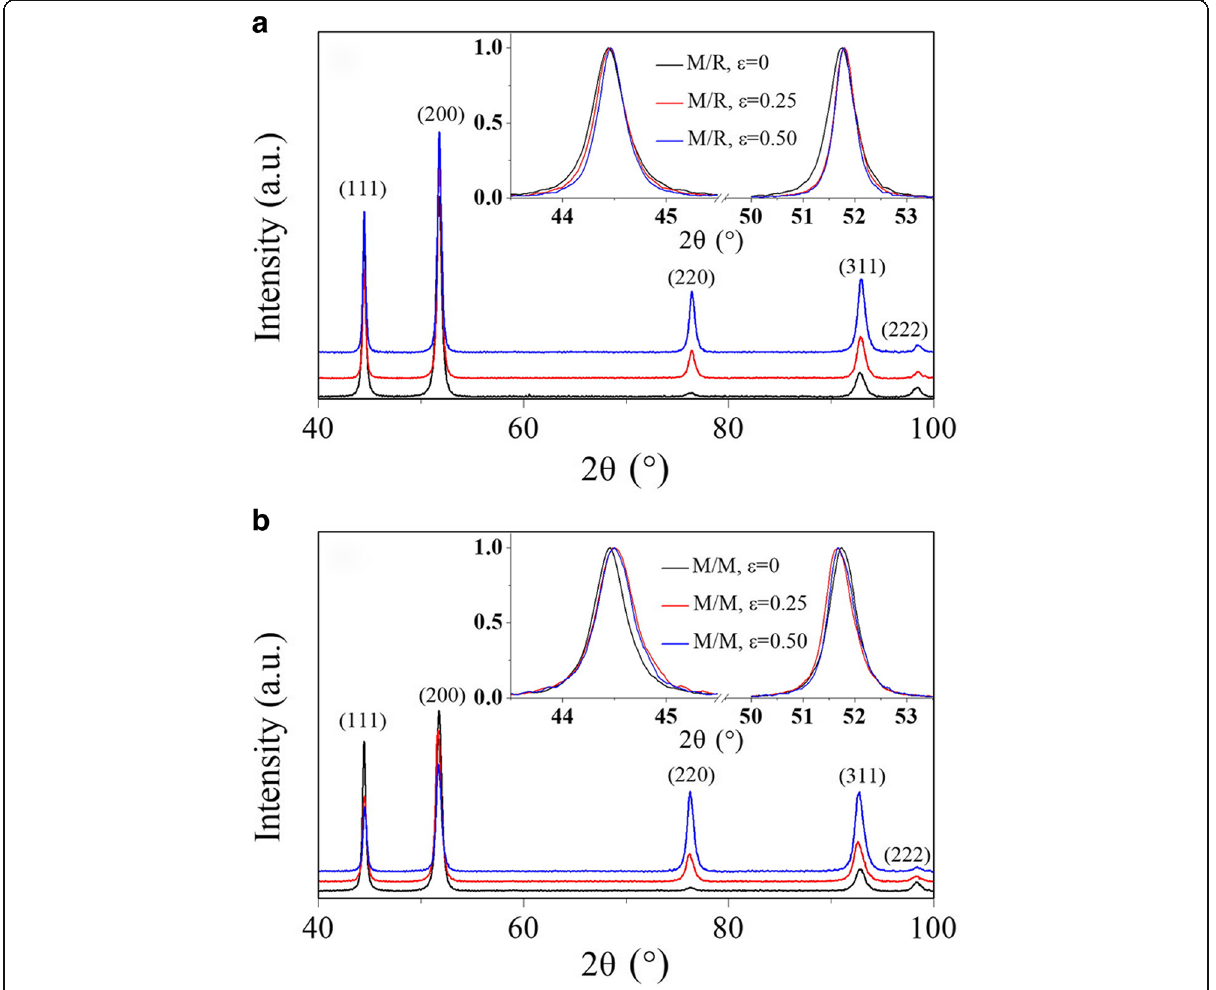
Fig. 1 Typical XRD patterns of a the metal/roll (M/R) contact interface and b the metal/metal (M/M) contact interface during the pack-rolling deformation of pre-annealed electrodeposited nanocrystalline nickel. Normalized peaks of (111) and (200) reflection planes are displayed at the upper right